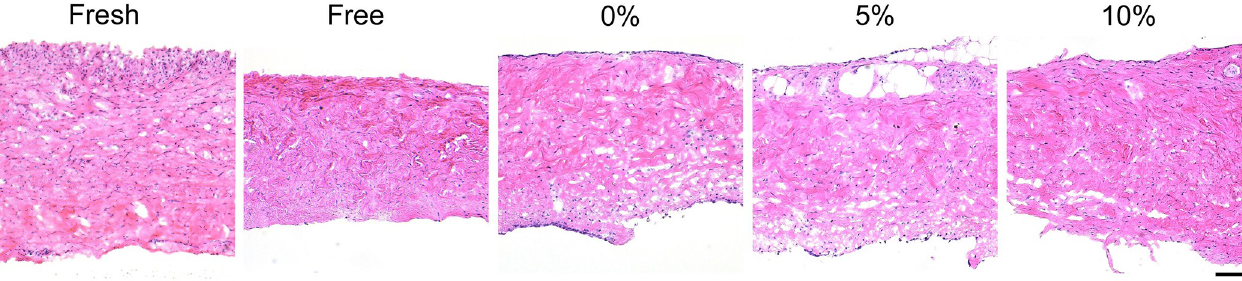
PLOS ONE | https://doi.org/10.1371/journal.pone.0279519 December30,